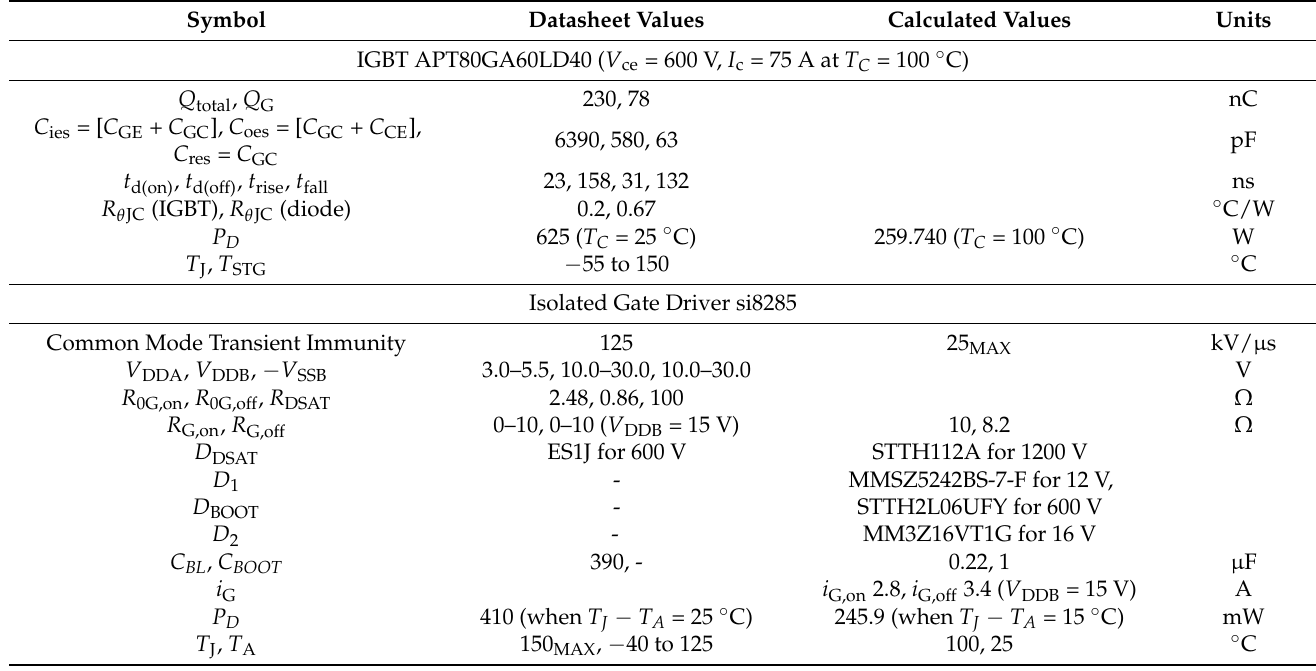
Table 2 summarize the bill of materials of the designed HB cell board. Table 2. The main electronic components of the HB cell